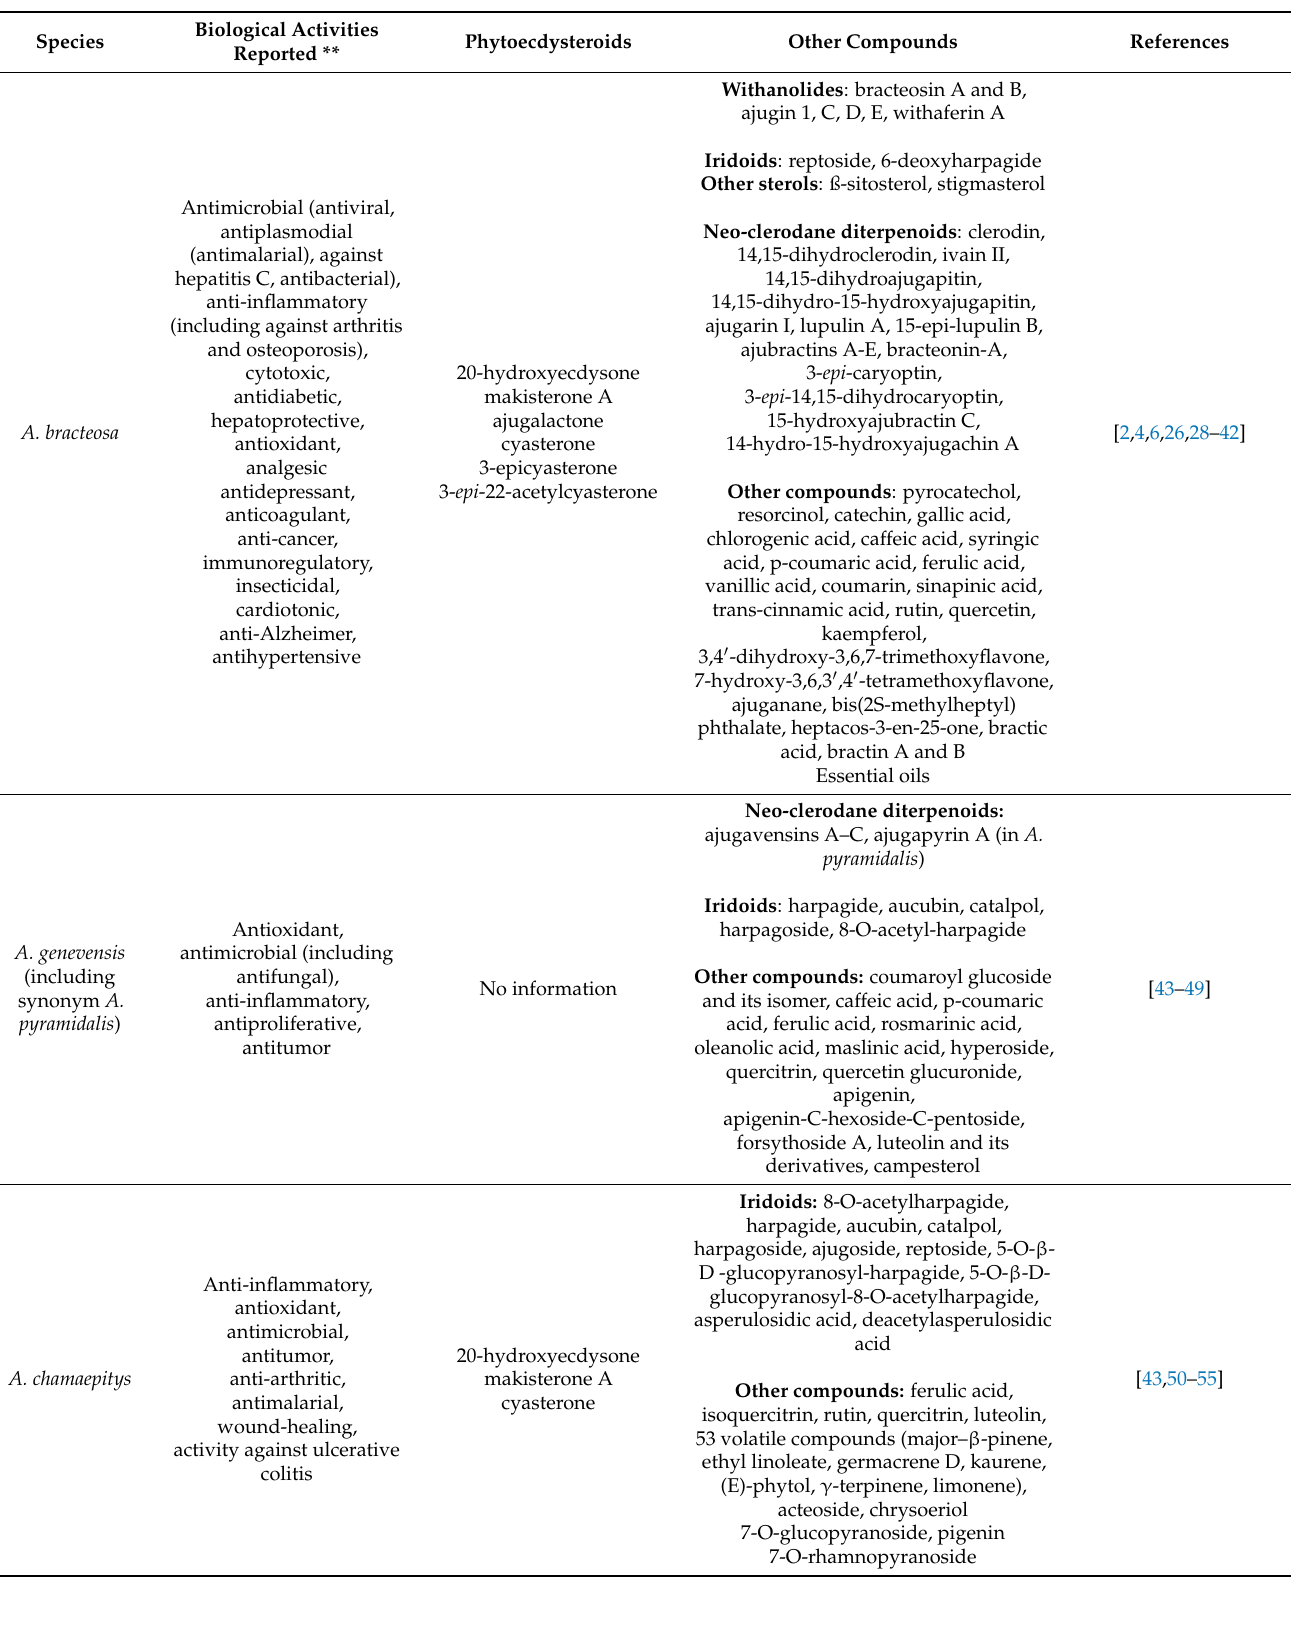
Table 1. Summary of biological activities and chemical composition reported for medicinal Ajuga species that were utilized in the cell culture technology